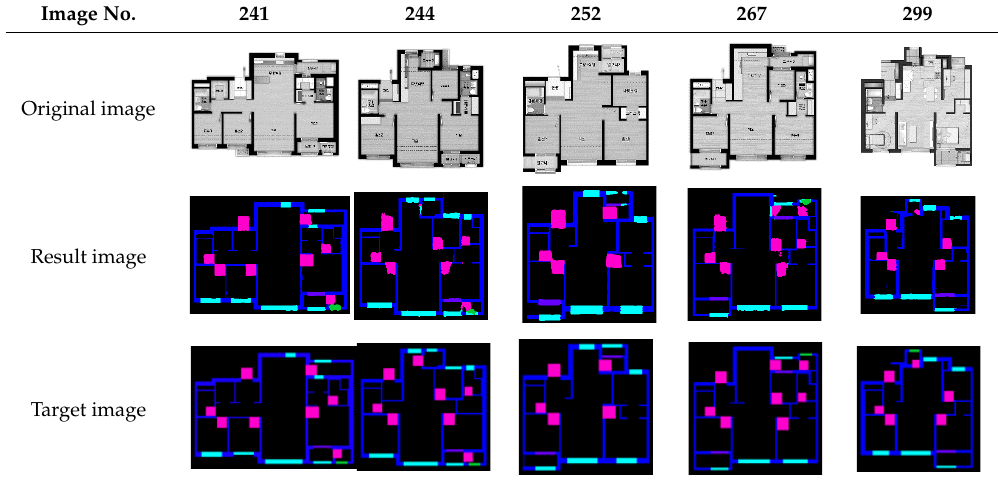
Figure 8. Deep Learning Process using DeepLabV3+.